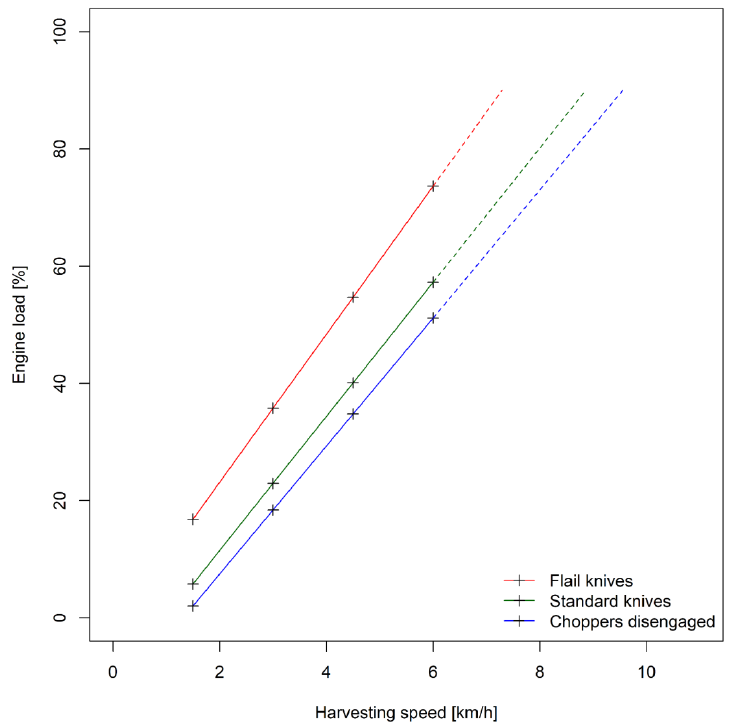
Figure A8. Percentage engine load of the combine harvester depending on harvesting speed for the levels of corn header configuration at cutting height level 4 (Markers indicate harvesting speed levels at cutting height level 4, dashed lines represent extrapolation up to a theoretical engine load of 90%).